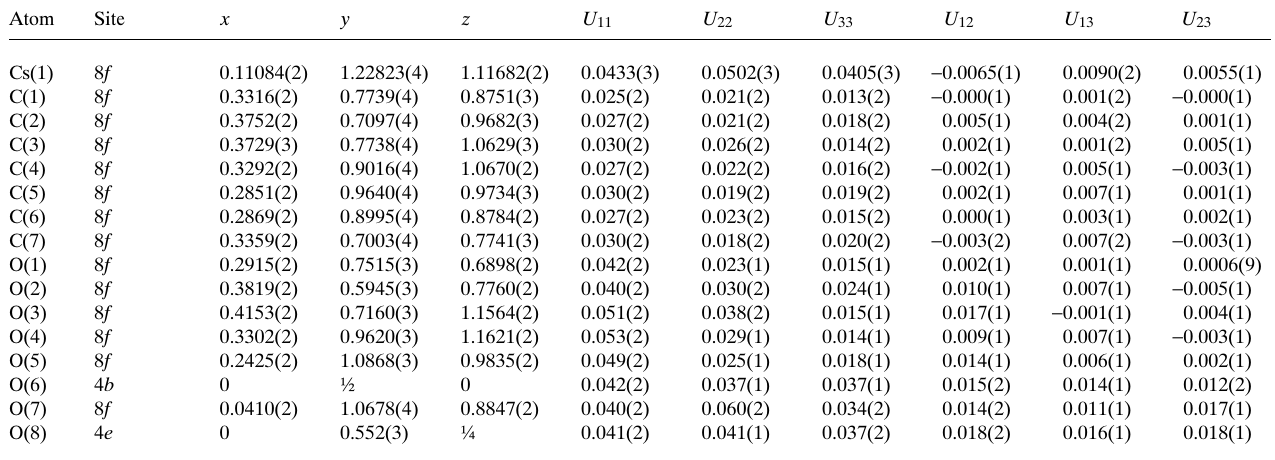
Table 3. Atomic coordinates and displacement parameters (in Å 2 ) .